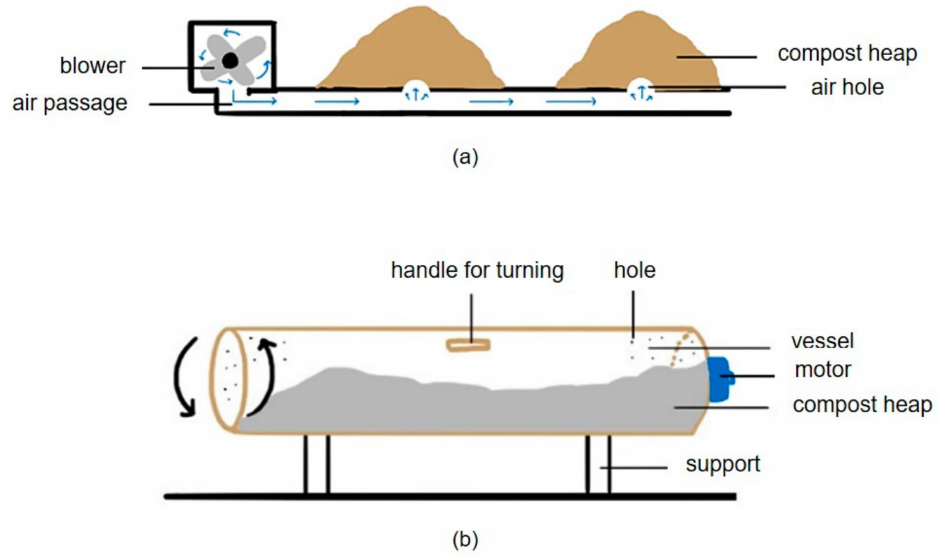
Figure 5. ( a ) Forced aerated windrow composting; ( b ) automatic turning in-vessel